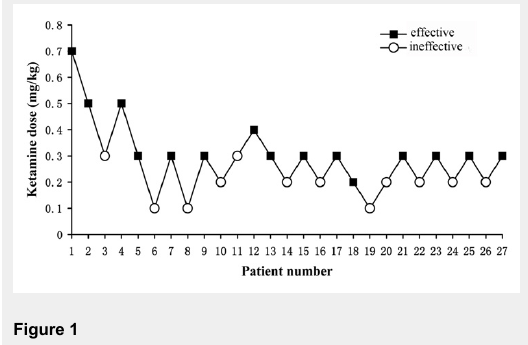
Dose-response curve of ketamine for prevention of postoperative hyperalgesia after remifentanil-based anaesthesia in patients undergoing laparoscopic cholecystectomy.